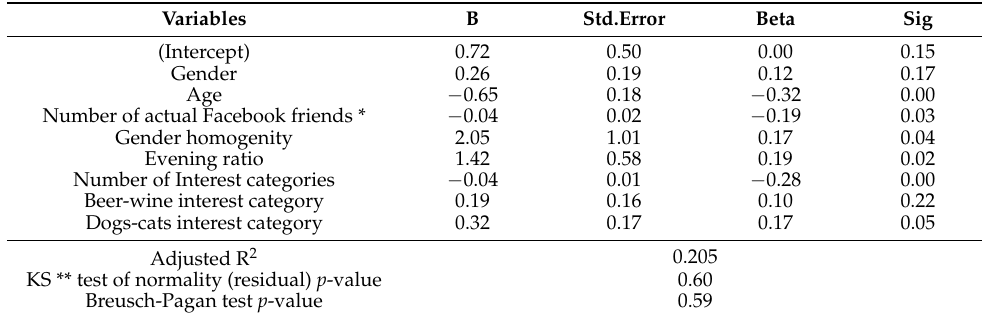
Table 9. Linear Regression model. Dependent variable: Cognitive-affective